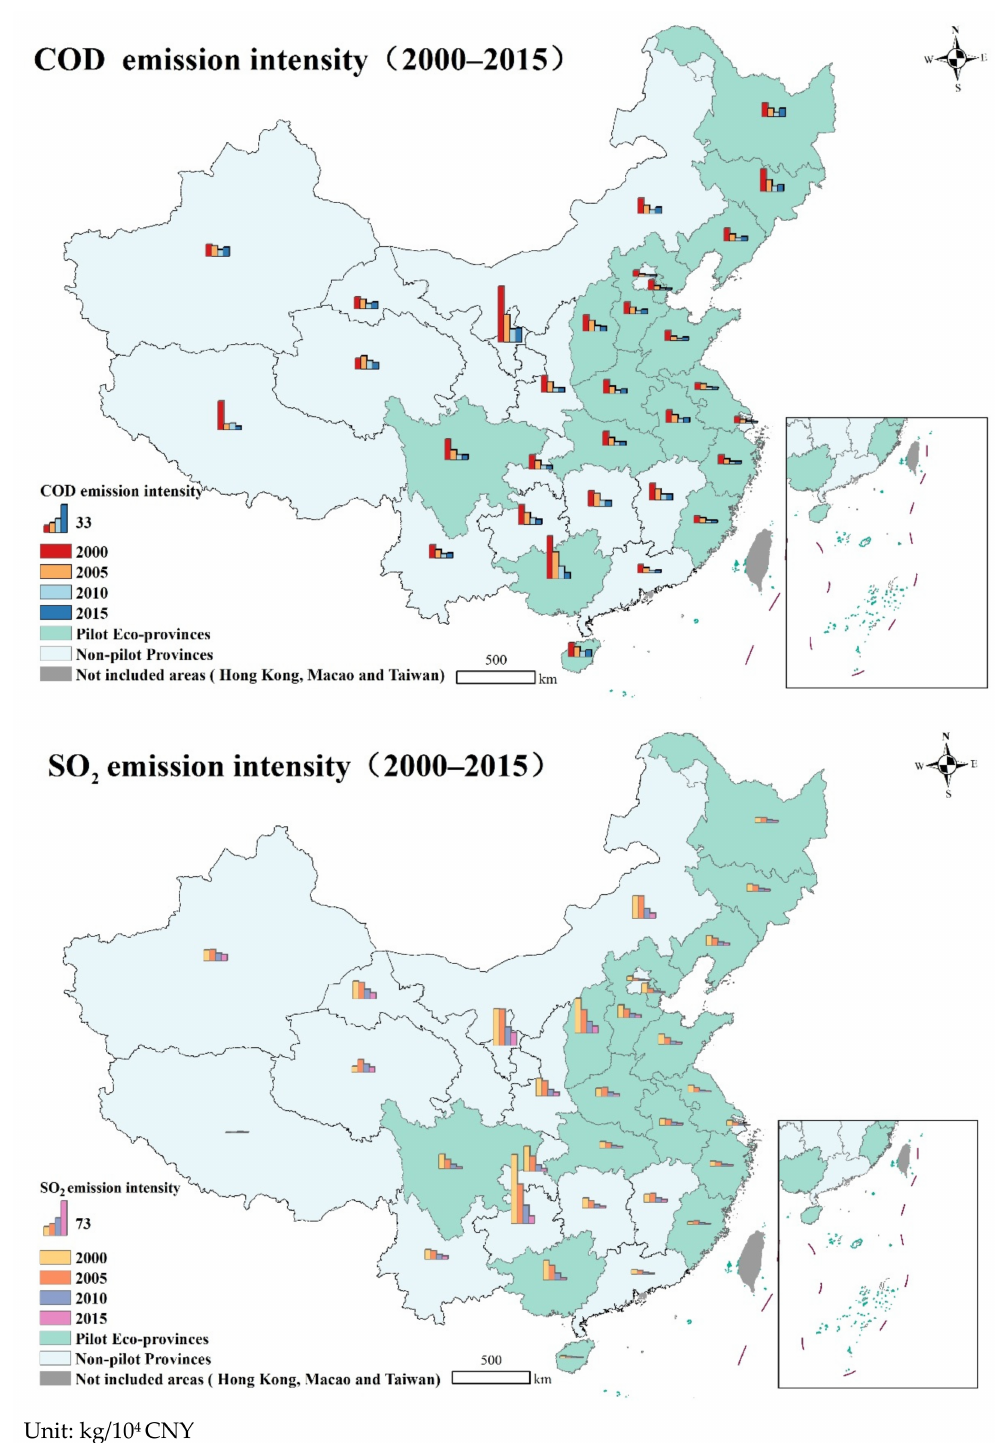
Figure 2. Pollutant emission intensities of provinces in China